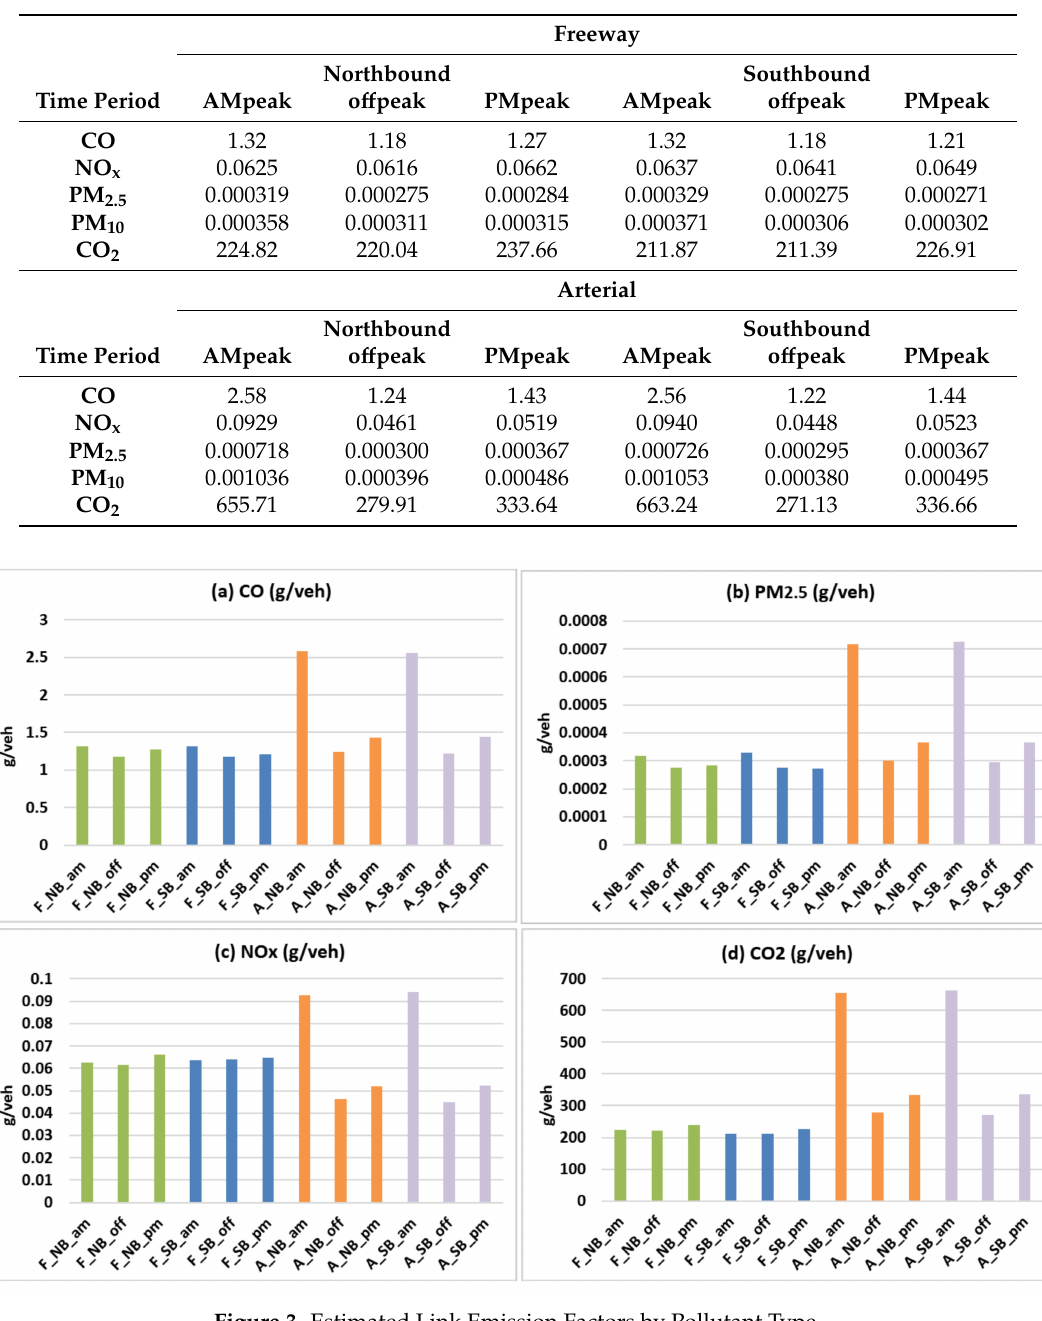
Table 4. Estimated link emission factors (g / veh).